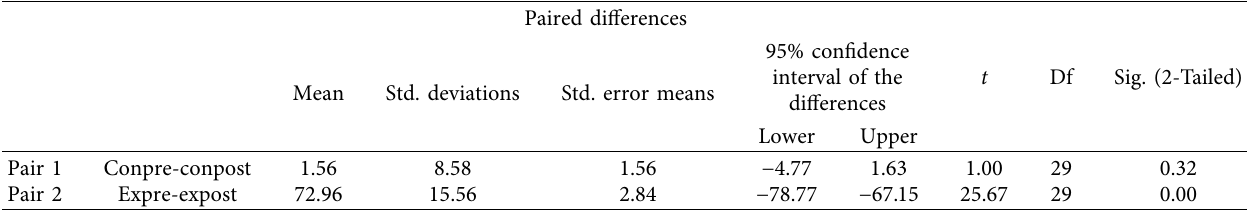
Table 5: Paired samples statistics of the experimental and control groups in the anxiety pre and posttests.